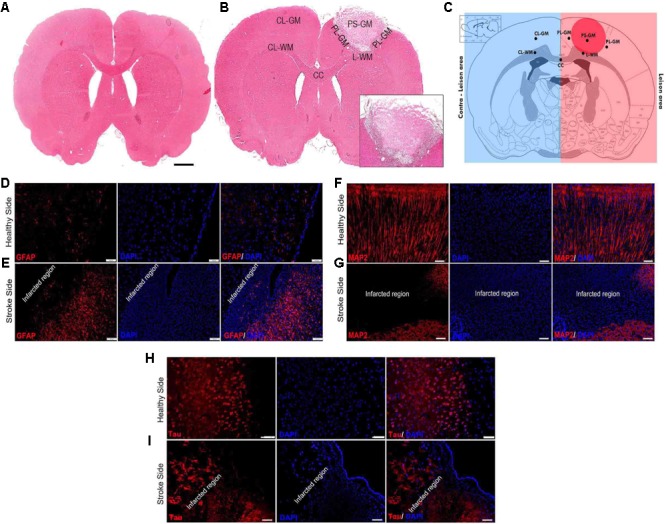
Photothrombotic lesion in rat somatosensory cortex results in cell death and astrigliosis. (A) Hematoxylin and Eosin (H&E) staining brain section of native control brain (magnification 5×). (B) H&E stained image 1-week post-stroke brain (magnification 5×). (C) Brain section scheme for the six regions of interest (ROI): primary stroke lesion gray matter (PS-GM), perilesional gray matter (PL-GM), lesioned white matter (L-WM) and contra-lesioned white matter (CL-WM), contra-lesioned gray matter (CL-GM), and corpus callosum white matter (CC). (D,E) Healthy control and lesioned brain sections labeled with GFAP and DAPI: primary lesion gray matter (PS), perilesional gray matter (PL) indicated activated astrocytes (GFAP, red stain) around the ischemic region (peri-infarct region) and degenerated neurons with shrunken nuclei (DAPI, blue stain). Infiltration of the astrocytes around the primary lesion PS-GM region with GFAP (red). The DAPI labels (blue) degenerated cells. (F,G) Healthy control and affected stroke rat brains sections were labeled with MAP2 and DAPI. (H,I) Healthy control and affected stroke rat brains sections labeled with Tau and DAPI to assist in comparisons. Scale bar = 100 μm.